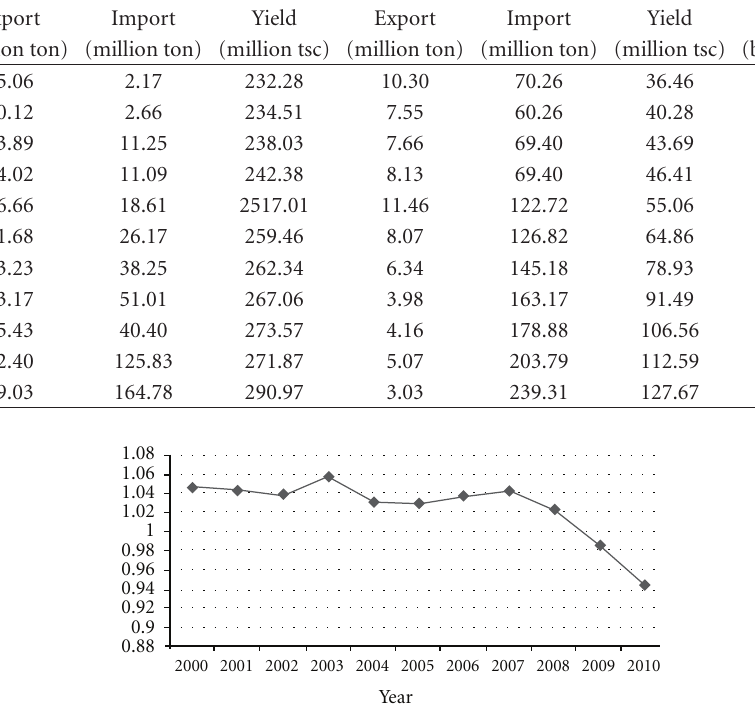
Figure 1: C/S ratio of fossil fuels in China during